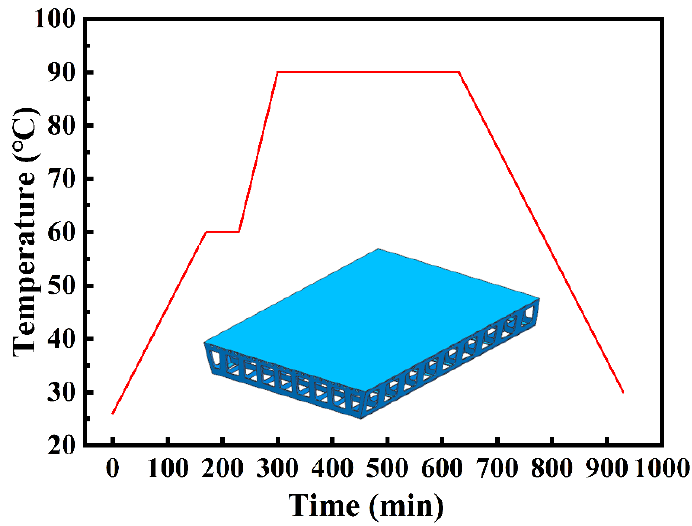
Figure 3. The curing cycle curve.